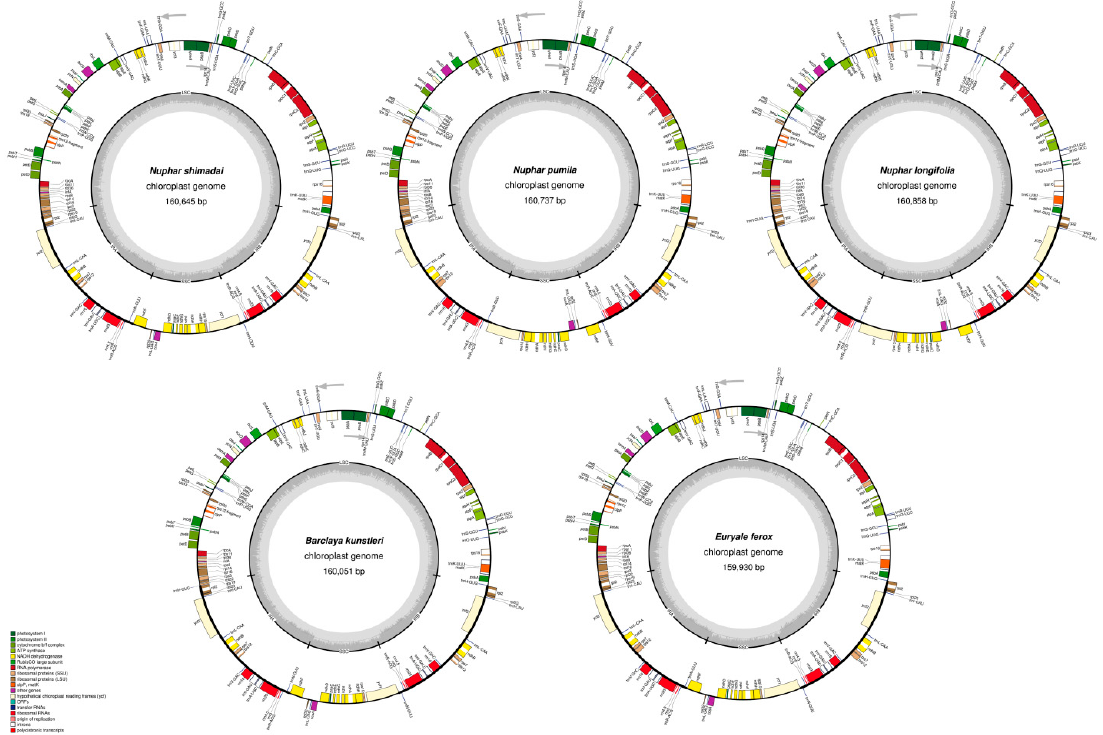
Figure 1. Circular gene maps of five chloroplast genomes of Nymphaeaceae. Grey arrows indicate the direction in which genes are transcribed. Color codes indicates the various gene functional groups, and the grey-shaded part in the inner circle shows the GC level of each chloroplast genome.